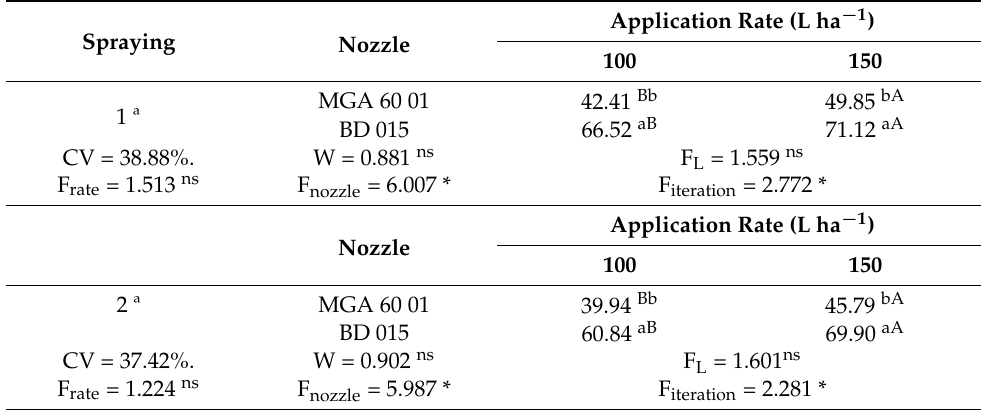
Table 2. Average values of deposited droplet coverage (%) after spraying the leaves of conilon coffee seedlings with sunscreen at 7th (1st) and 30th (2nd) days after planting in pots in the field. Spraying